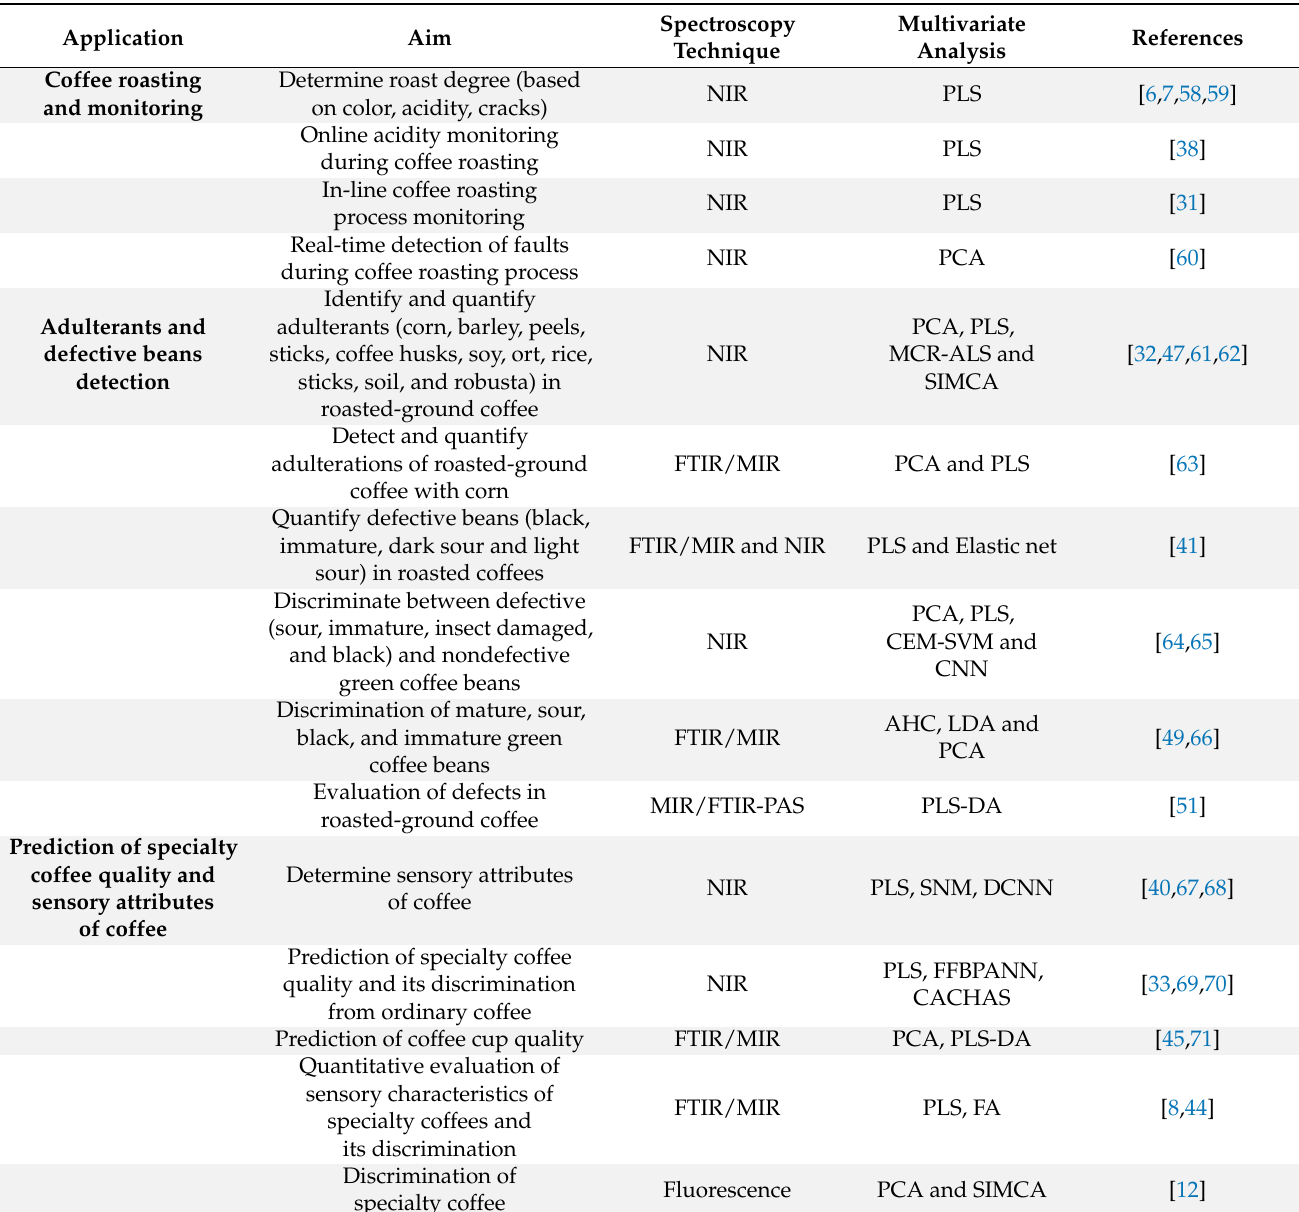
Table 2. Summary of reported studies on potential applications of NIR, FTIR/MIR, fluorescence and Raman spectroscopy in the coffee